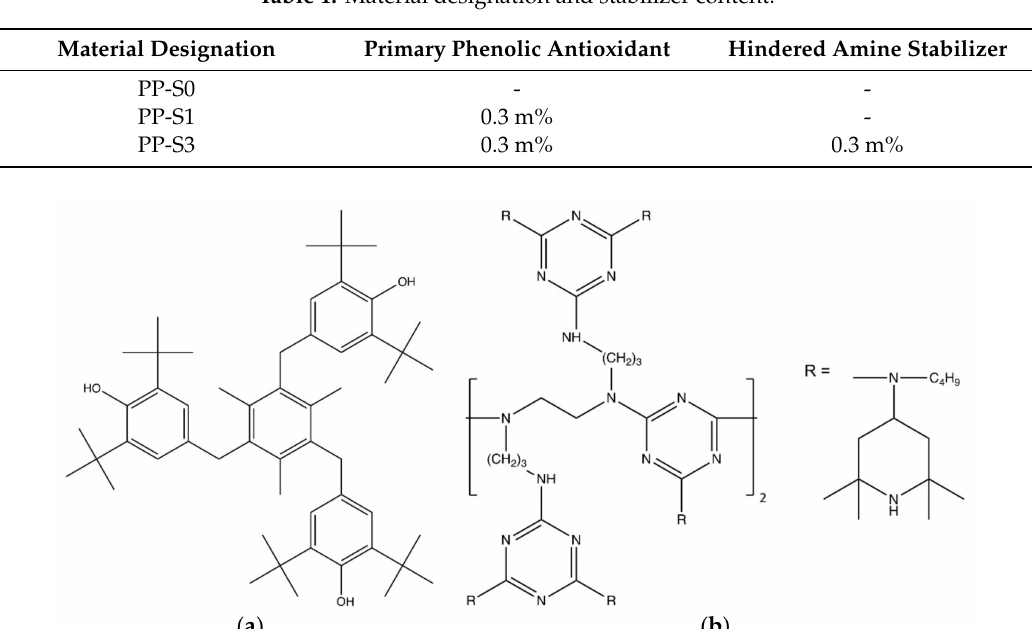
Table 1. Material designation and stabilizer content.